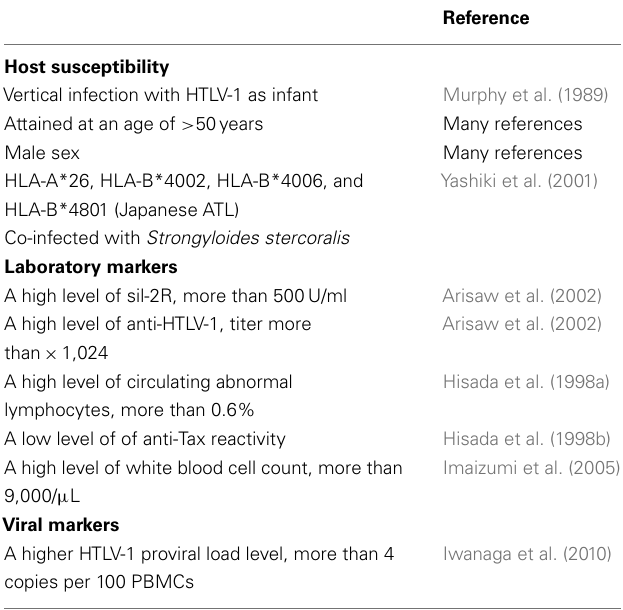
Table 2 | Risk factors for the development ofATL with regard to the HTLV-1 carrier